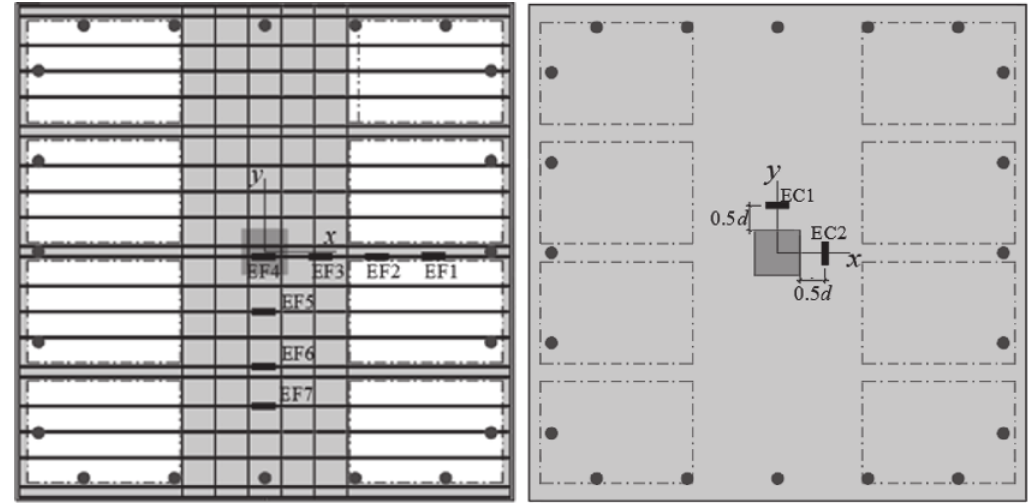
Posicionamento dos extensômetros na armadura e no